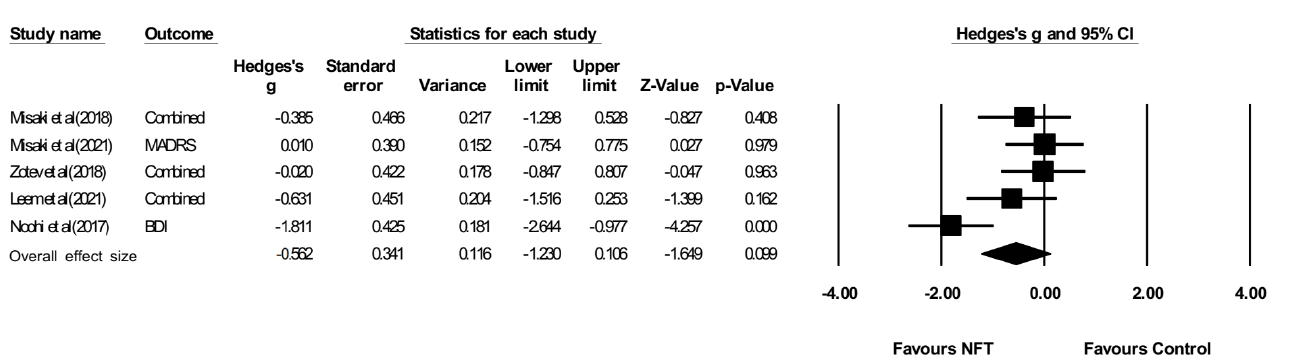
Figure 7. Forest plot for meta-analysis of the effect of neuro-feedback training on anxiety and depression. Misaki et al (2018) [26]; Misaki et al (2021) [27]; Zotev et al (2018) [28]; Leem et al (2021) [31]; Noohi et al (2017) [32].